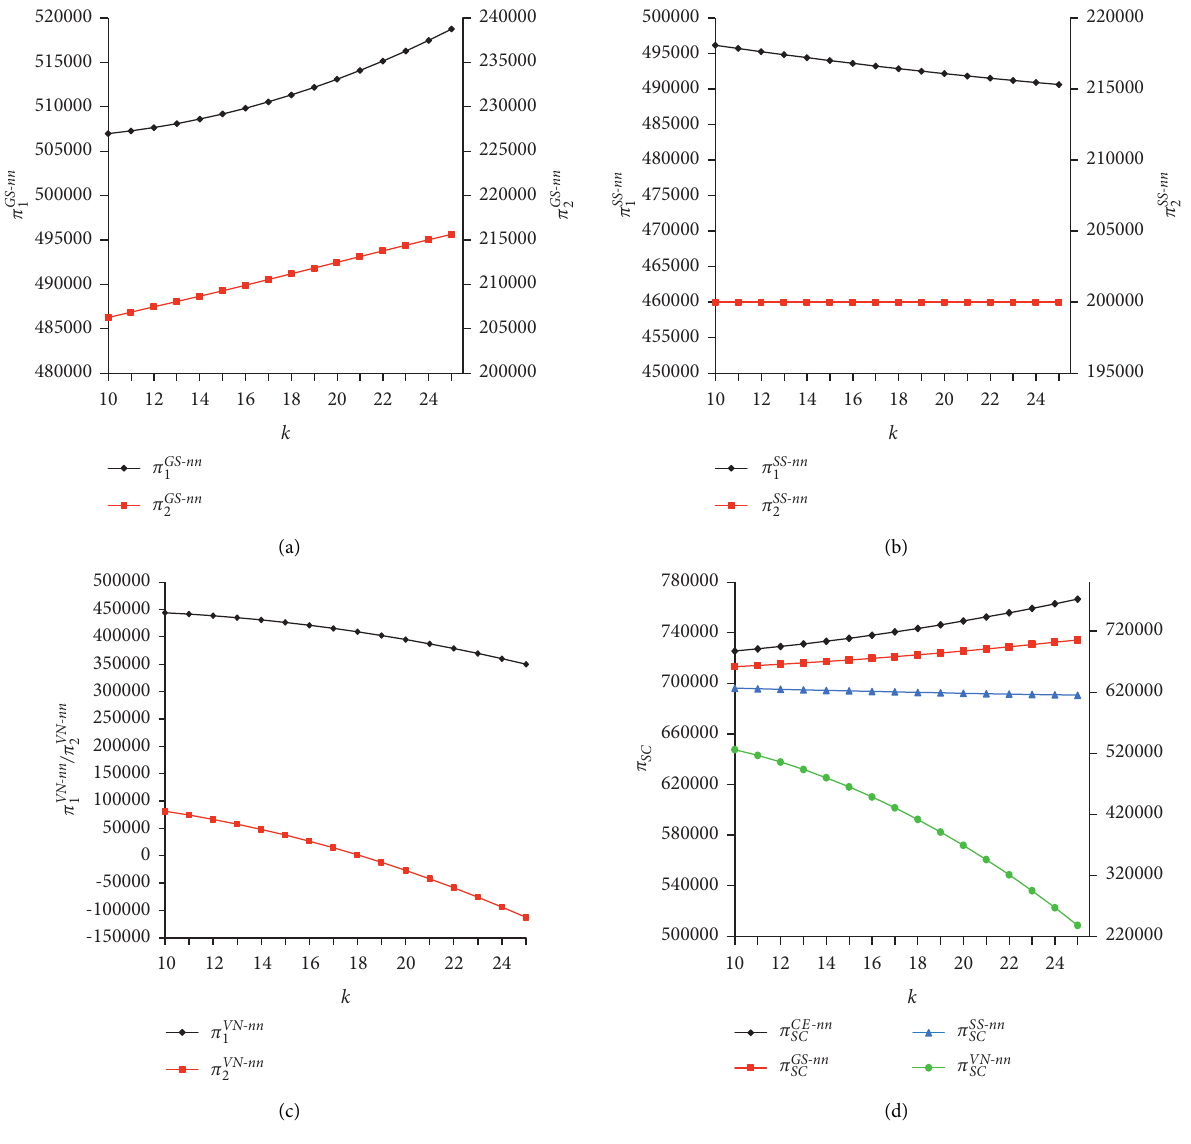
Figure 3: Effects of k on profit